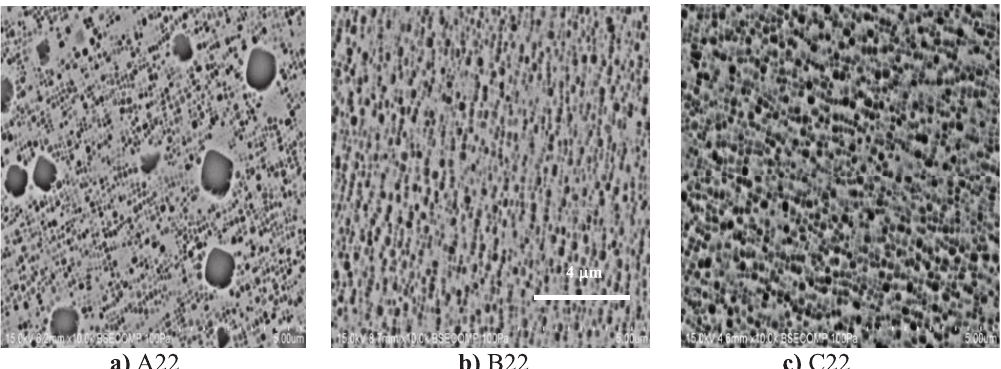
Figure 20. Microstructures of specimens after reheat treatment of Program